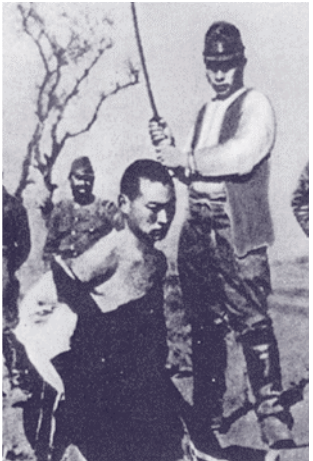
Figure 8. Beheading a Chinese soldier. Source: Robyn Beck/Getty Images.